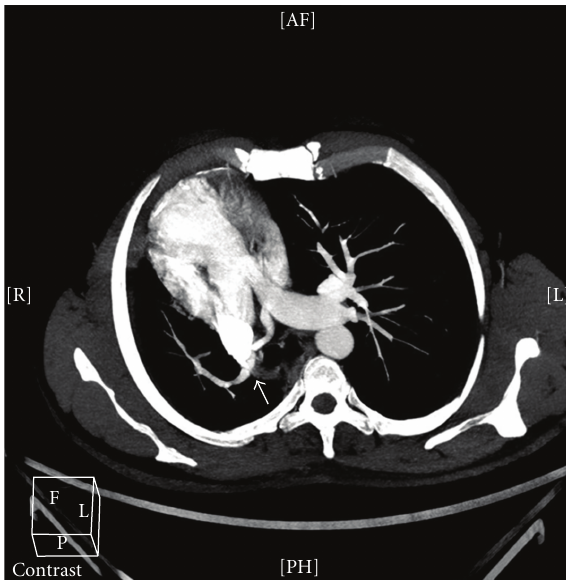
Figure 1: Axial plane showing cardiac dextroposition and hypopla- sia of the right lung and right pulmonary artery (white arrow).